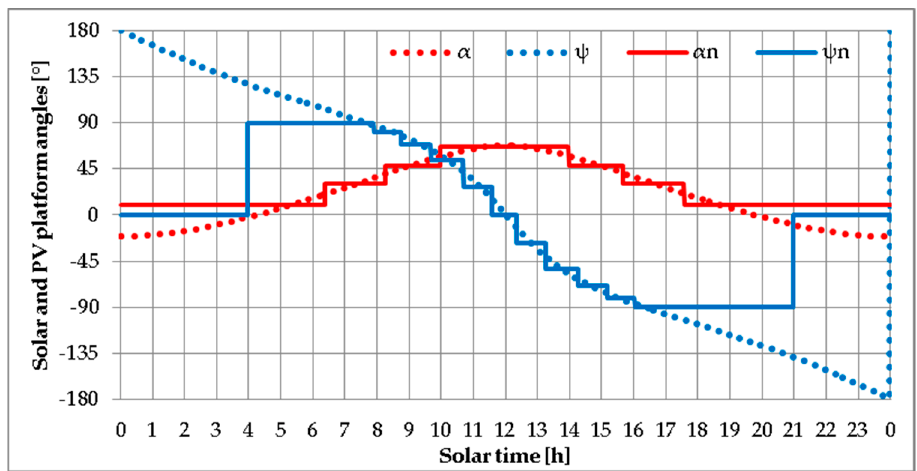
Figure 5. Solar-tracking programme of the PV platform during the summer solstice (21 June 2022). The meteorological parameters are locally measured using a Delta-T weather station